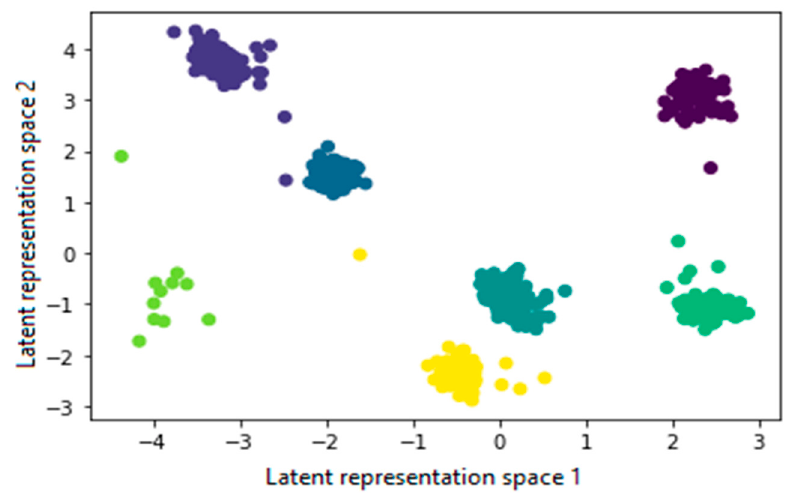
Figure 5. Result of deep clustering. 1. Case Study 1: Normal Operation (day and night-time windows)